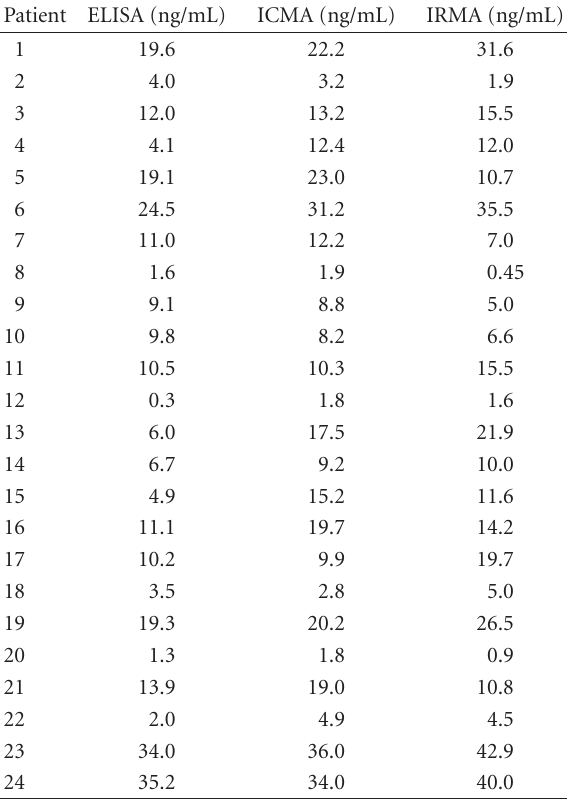
Table 3. Di ff erences found among ELISA, ICMA, and IRMA. Patient ELISA